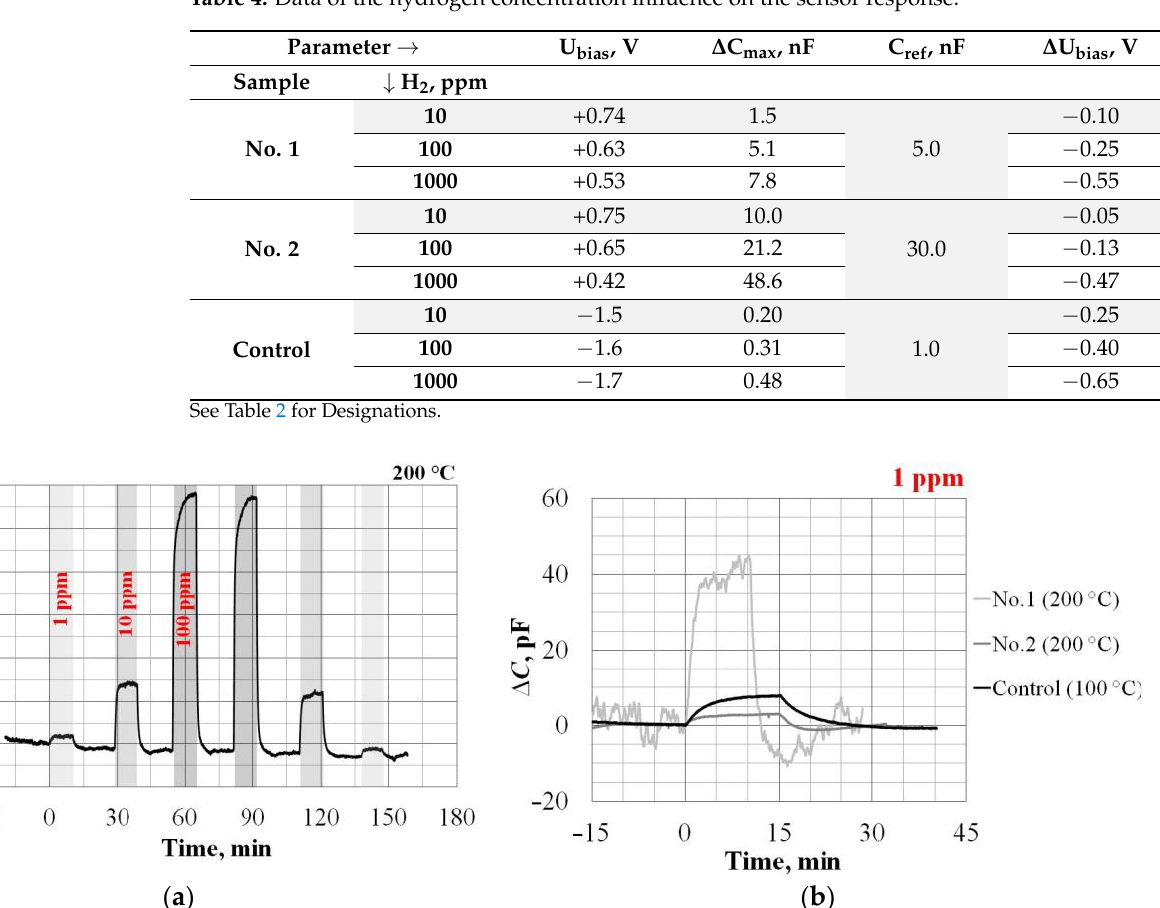
Figure 7. The experimental samples' hydrogen sensitivity calibration: Sample No.1 (a), Sample No.2 (b), and Control sample (c). Lines 1 and 2 (a) show the U bias value influence on the recorded signal ΔС value at different hydrogen concentrations (see explanations in Section 3). Table 4. Data of the hydrogen concentration influence on the sensor response.